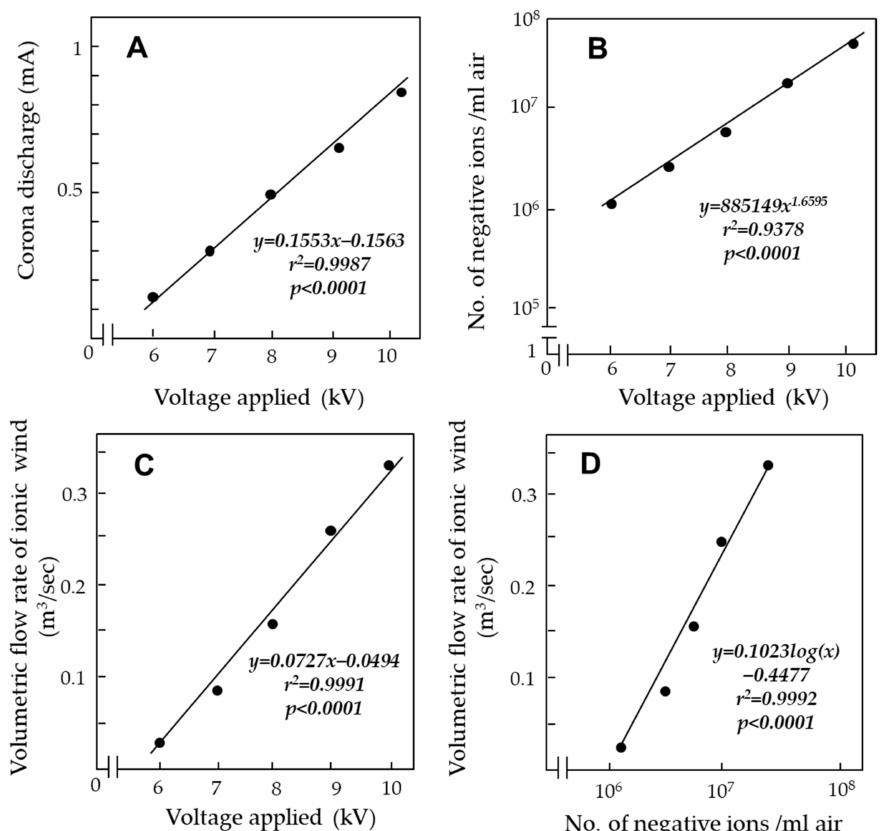
Figure 4. Relationship between the applied voltage and corona discharge ( A ), negative ion generation ( B ), and volumetric flow rate of ionic wind ( C ) in the electric field of the CDA. ( D ) Relationship between the volumetric flow rate of ionic wind and negative ion